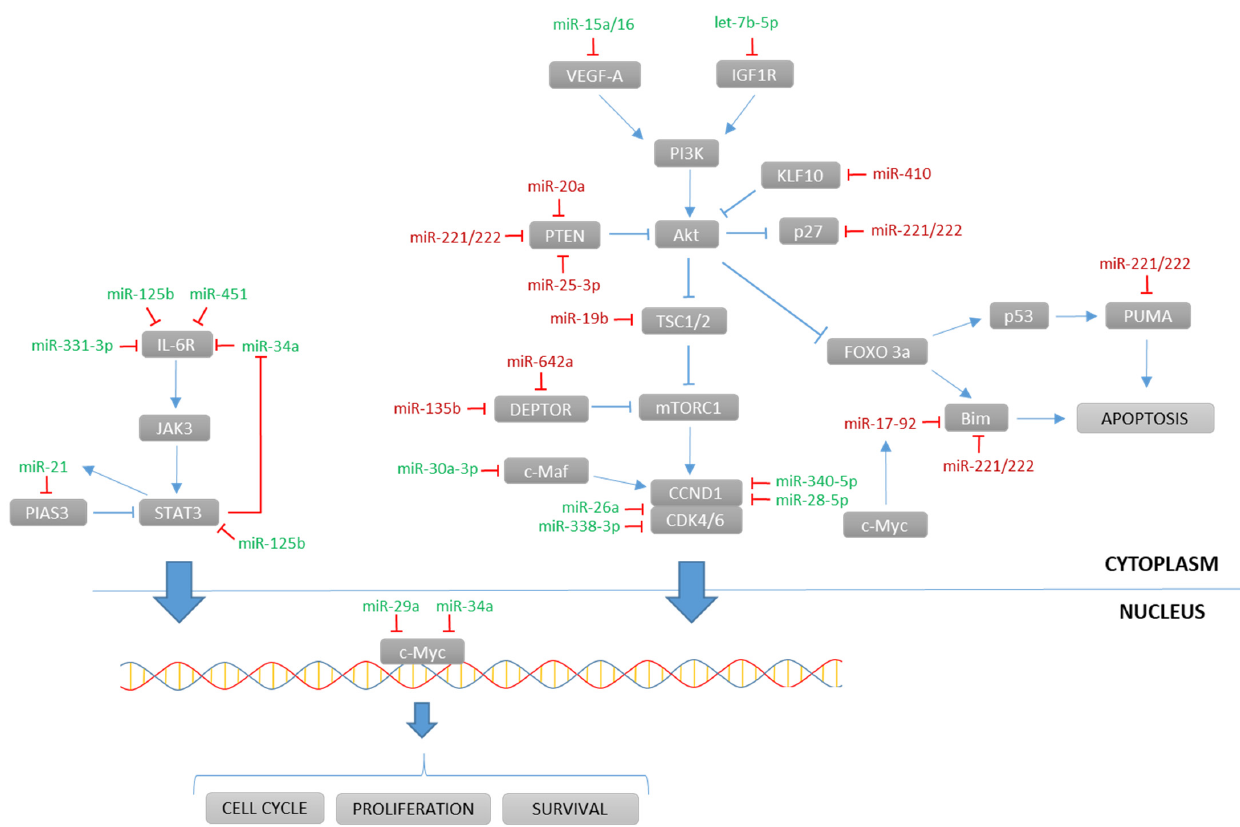
Figure 1. Overview of the main signaling pathways altered by miRNAs in MM cells. Oncogenic miRNAs (red) are overexpressed, and tumor-suppressive miRNAs (green) are underexpressed in MM cells. MM